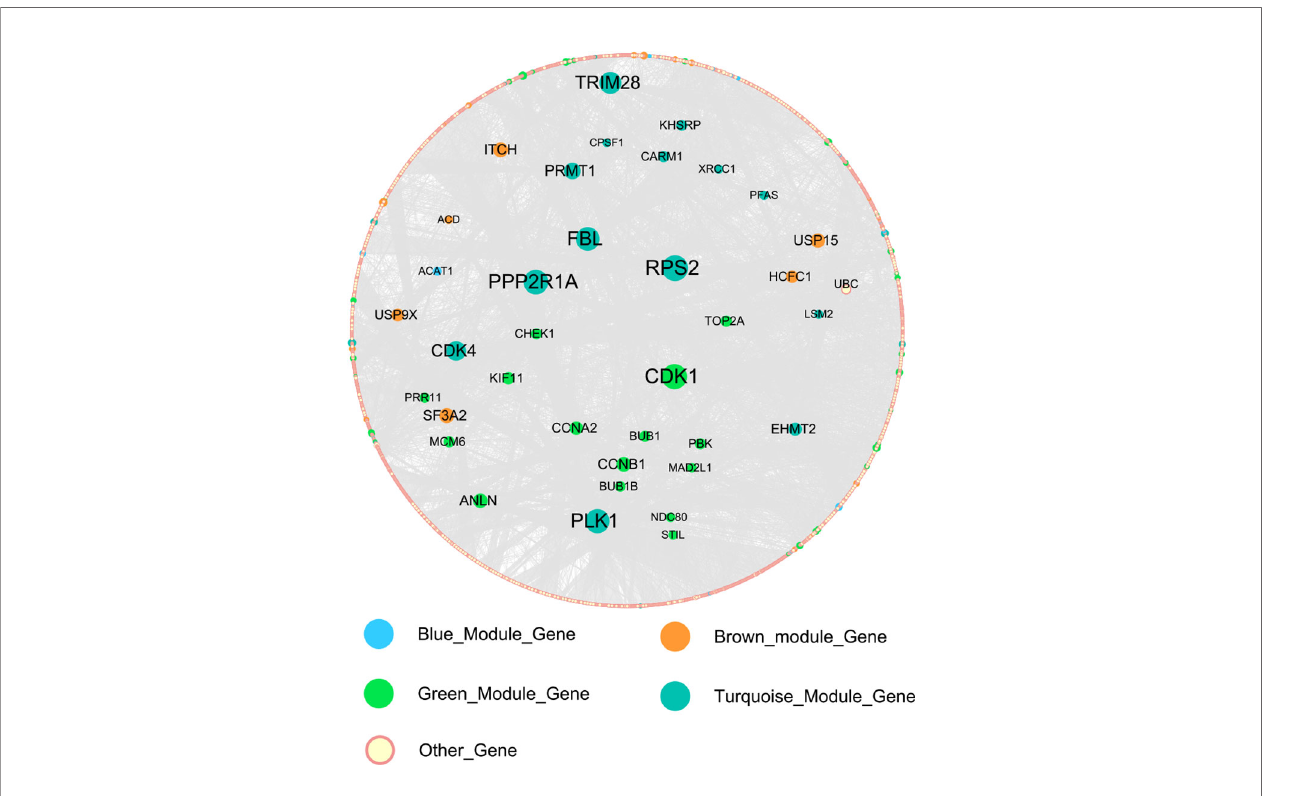
FIGURE 6 | The protein-protein interaction (PPI) network of the 114 hub genes.